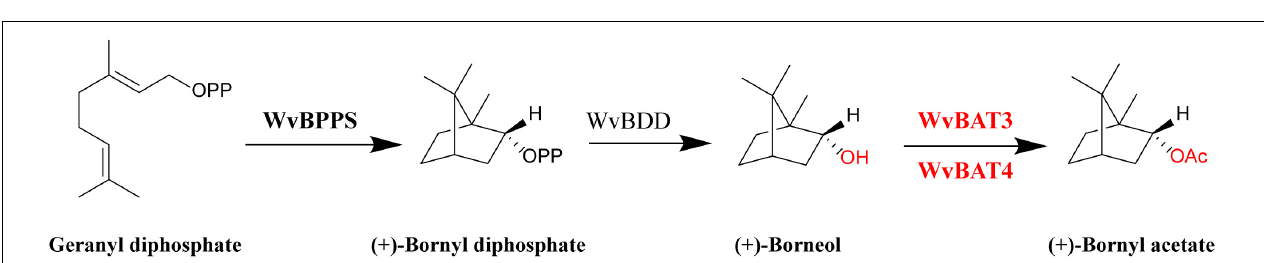
FIGURE 8 | (A) The number of cis- acting elements in WvBATs , indicated by the intensity of the red color and numbers in the grid. The cis-acting elements with seed-special expression were indicated by a red asterisk. (B) Histograms indicate the number of cis- acting elements involved in plant growth and development, phytohormone responsiveness, or stress responsiveness. (C) Pie charts showing the ratio of different cis- acting elements in each structural category.